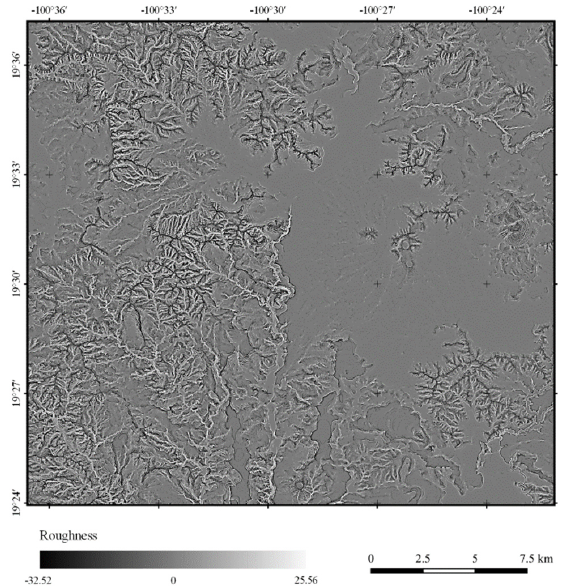
Figure 10 . Stretched image corresponding to DEM with 5 m resolution and 3×3 moving